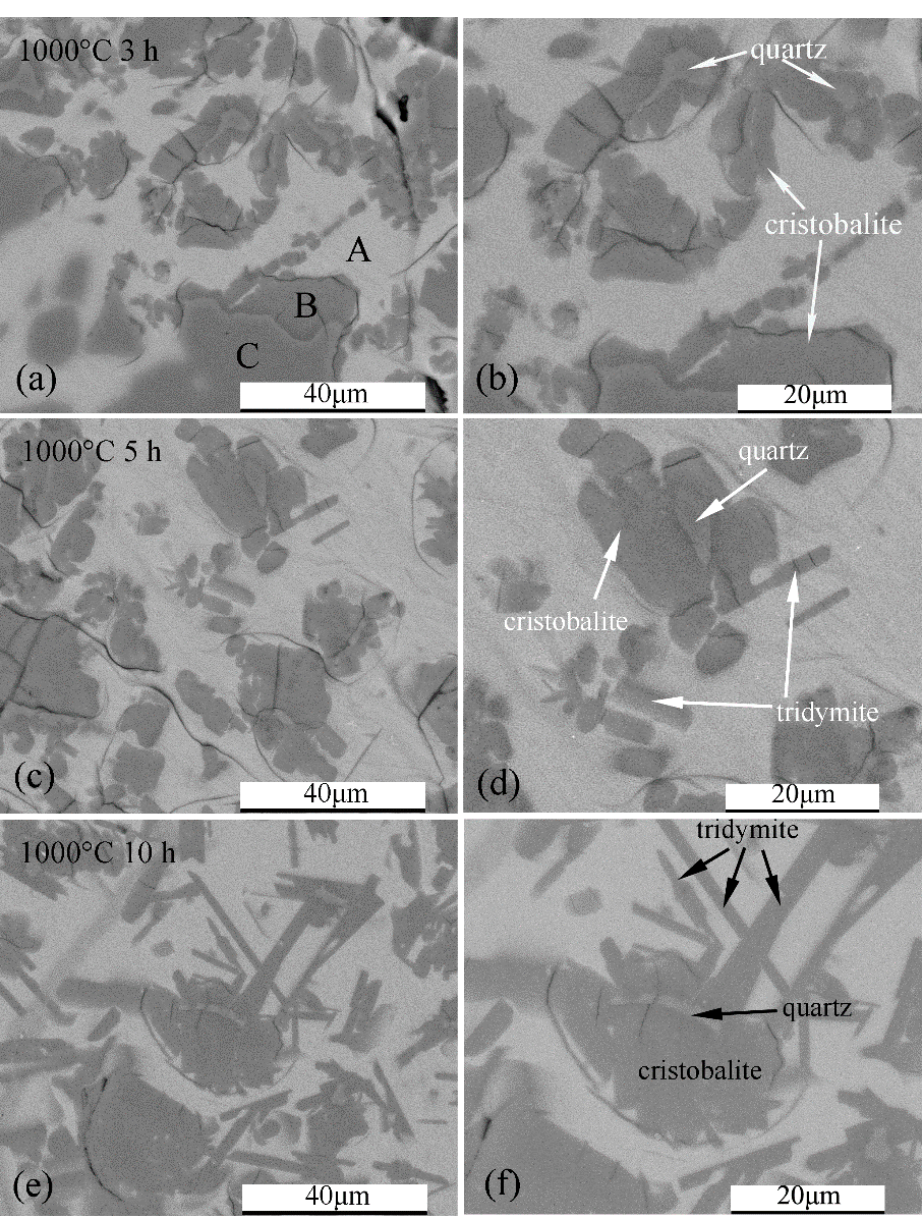
Figure 5. Microstructure of the coarse quartz—potassium silicate glass composites after holding at 1000 °C for different time: 3 h ( a , b ), 5 h ( c , d ) and 10 h ( e , f ).